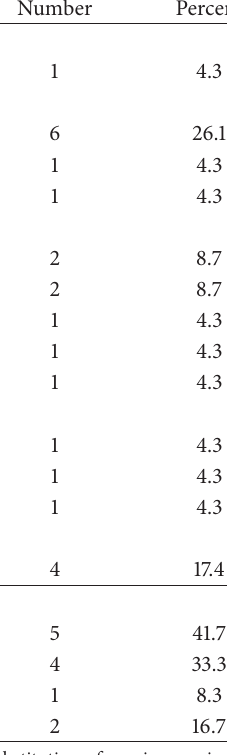
Table 7: Regimens prescribed in case of nonresponse to treatment by paediatricians in Mumbai. Regimen